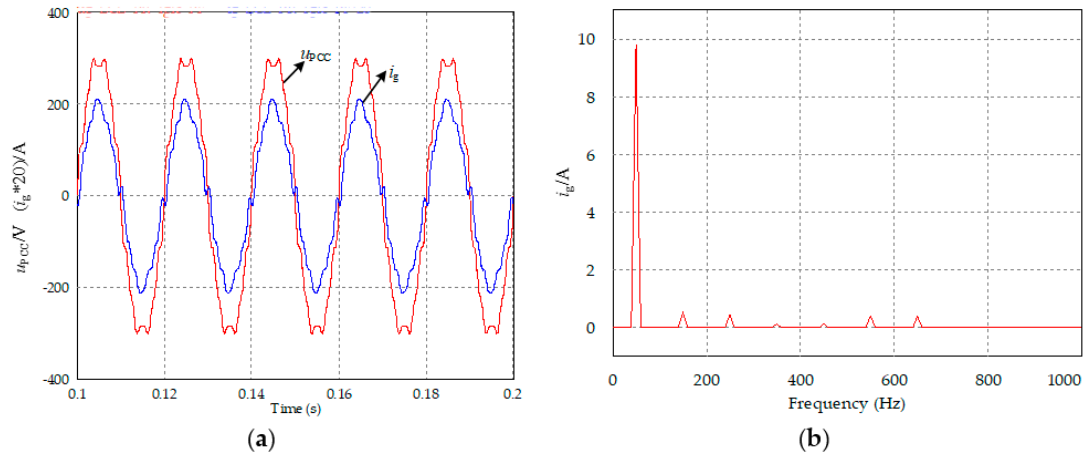
Figure 15. Simulation results of dual-loop control strategy. ( a ) Waveforms of grid voltage and current. ( b ) FFT (Fast Fourier Transformation) analysis of grid current (THD = 7.4%).